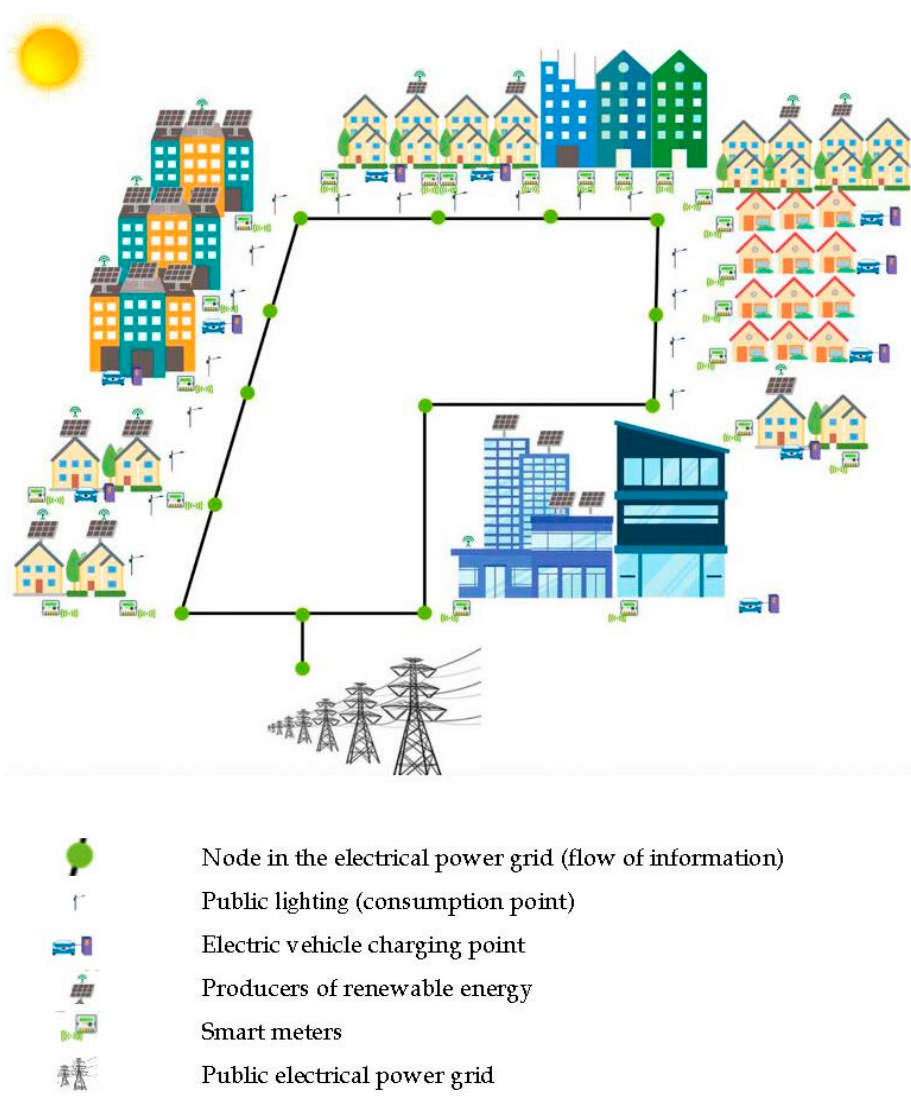
Figure 4. Renewable energy community